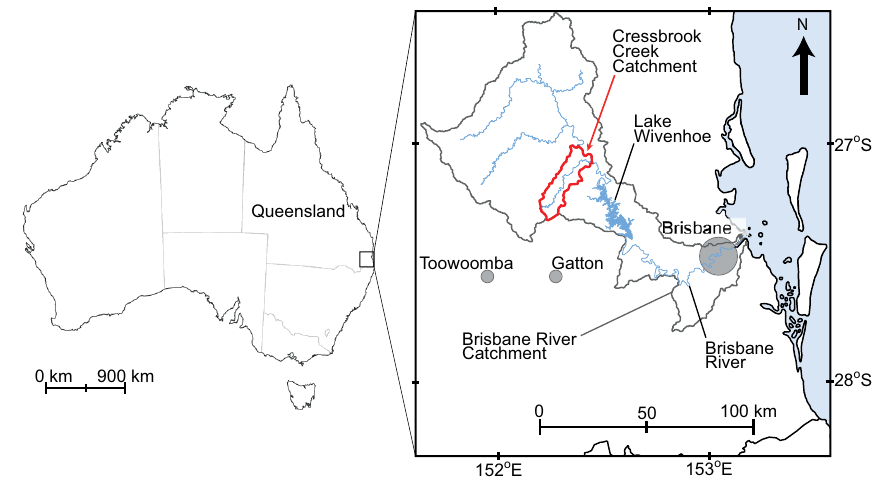
Figure 1. Cressbrook Creek catchment in Southeast Queensland, located approximately 80km northwest of Brisbane and within the upper Brisbane River catchment.